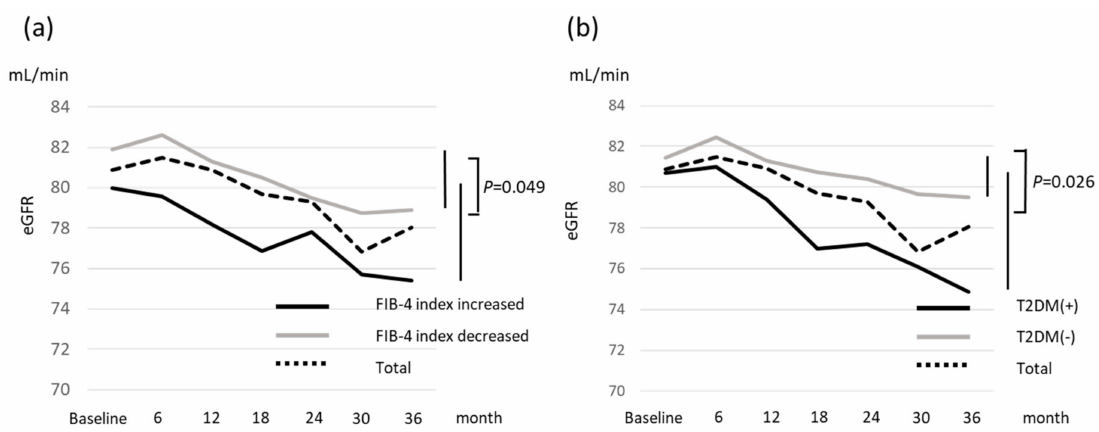
Figure 3. The median estimate glomerular filtration rate according to ( a ) change in FIB-4 index, and ( b ) presence of type 2 diabetes